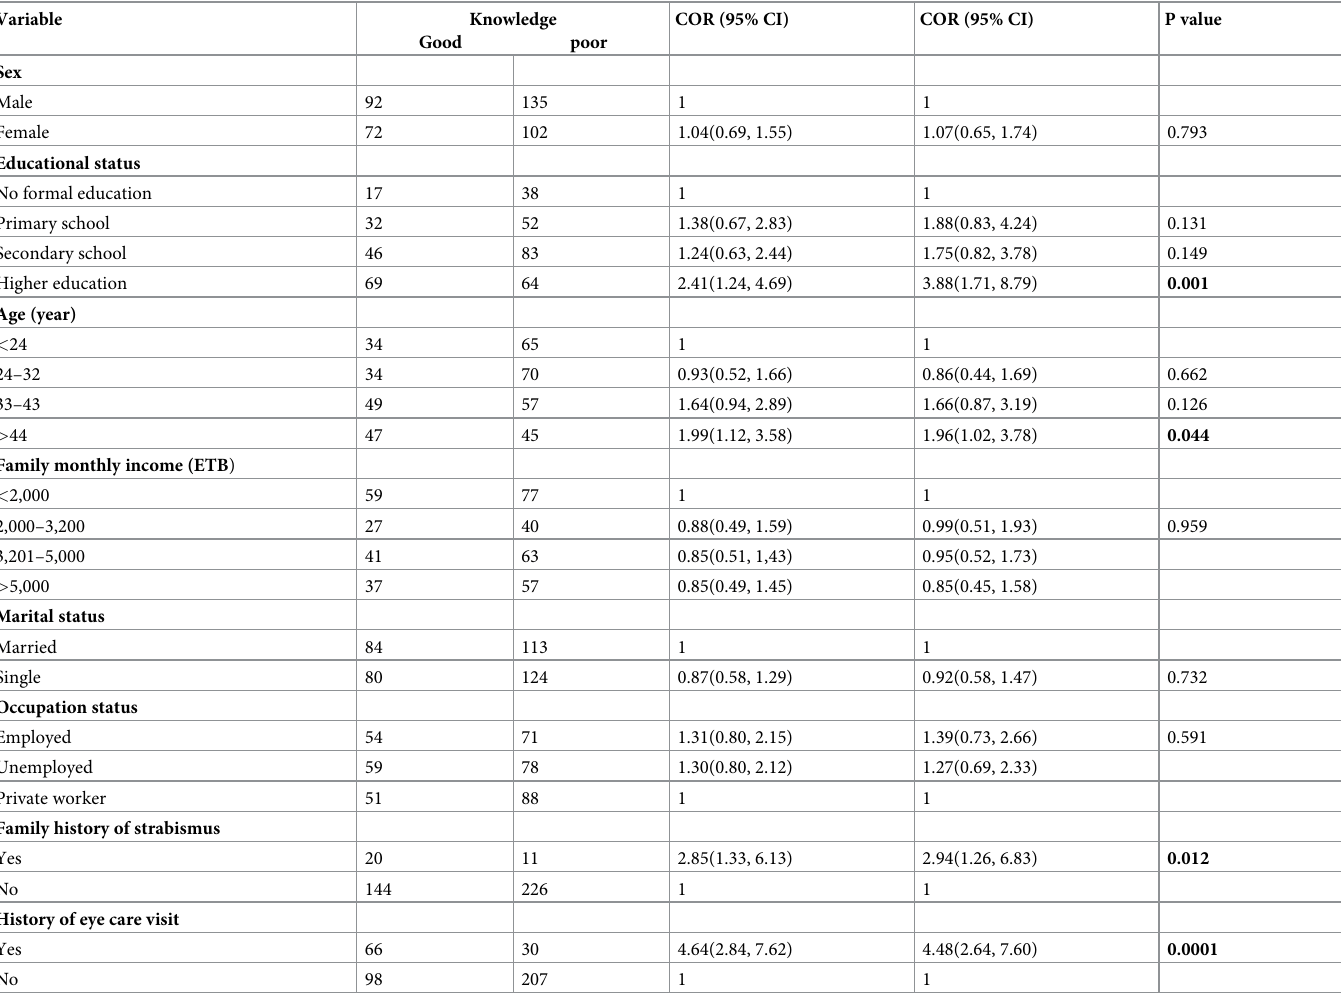
Table 5. Factors associated with knowledge of strabismus among adult participants living in Woreta town, Northwest Ethiopia, 2020 (n =